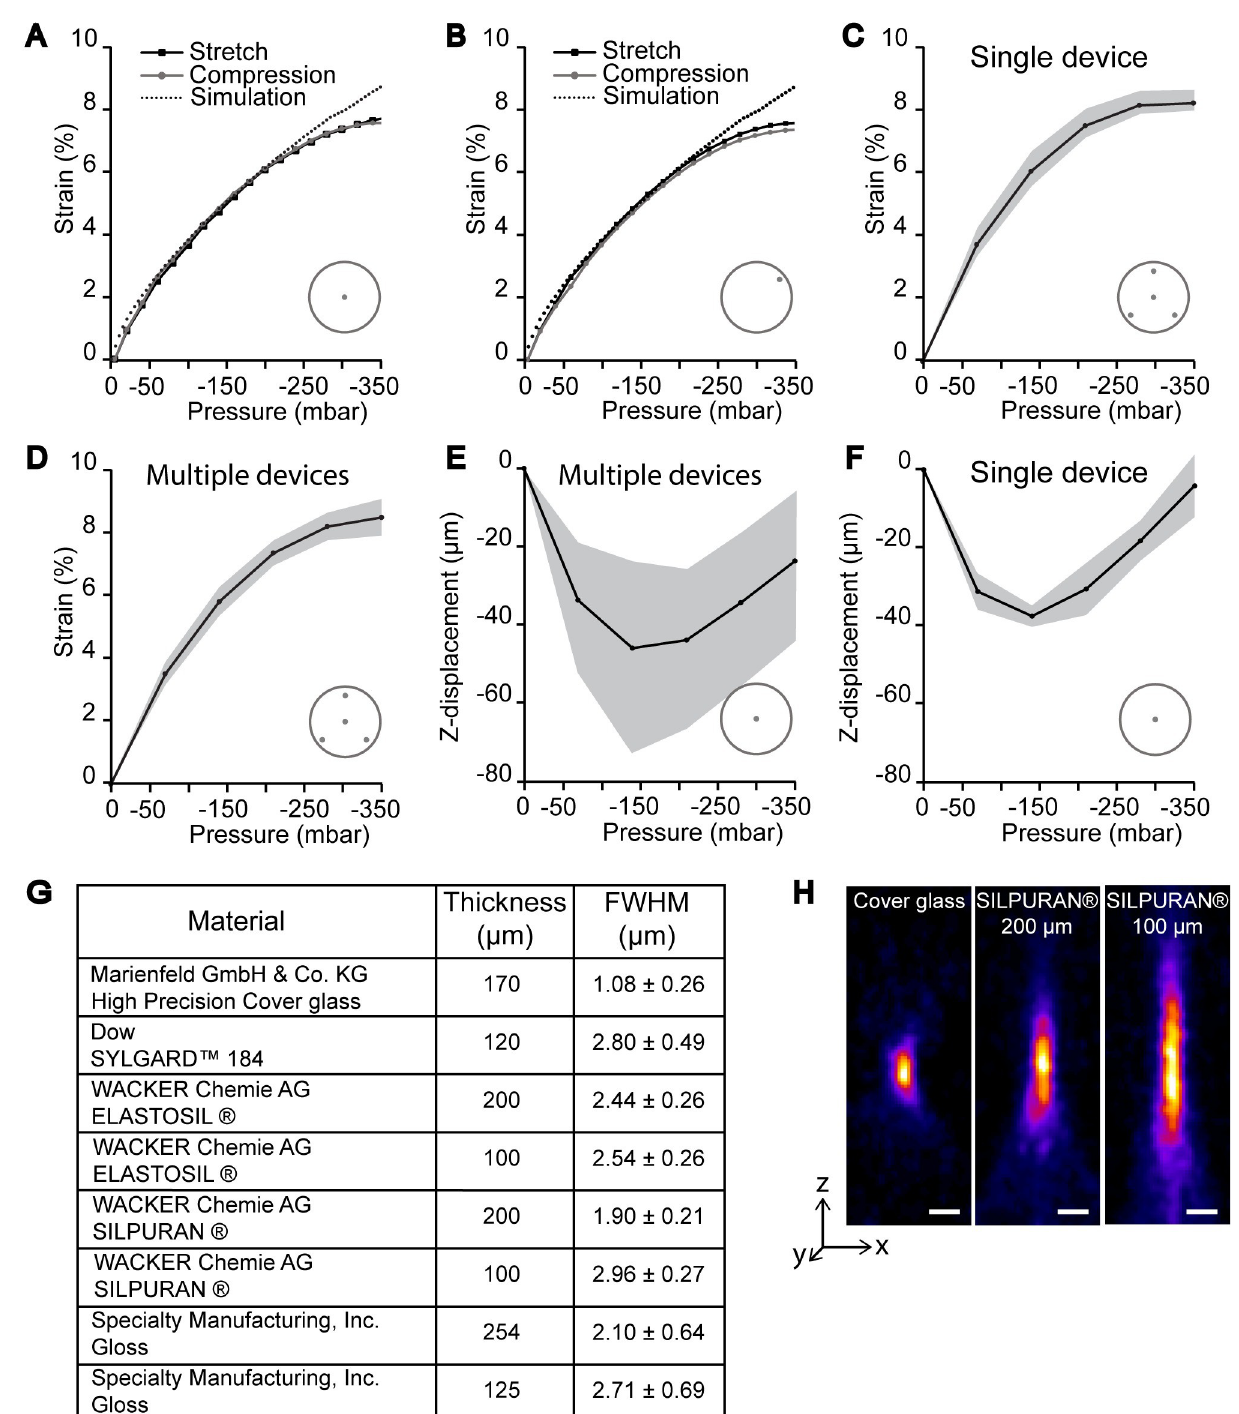
Fig 3. Functional characterization of the device. A) Pressure-strain graph of simulation data (dashed line) compared to experimental data measured from the center of the device and (B) edge of the device. Strain was measured as pressure was decreased (stretch) and as it was released (compression) to detect possible hysteresis (C) Pressure-strain graph showing mean and SD (grey area) of repeated measurements (n = 3) performed on a single device from four measurement locations. (D) Pressure-strain graph showing mean and SD (grey area) of measurements performed on six different devices. Each device was measured from four measurement locations. (E) Mean and SD (grey area) of the movement of the device membrane along the imaging axis (z-direction) in the center of the device (n = 6). (F) Mean and SD (grey area) of the z-directional movement in the center of a single device measured repeatedly (n = 3). G) Table with FWHM values along the z-axis for cover glass and different silicone membranes. 200 μ m thick SILPURAN 1 has the